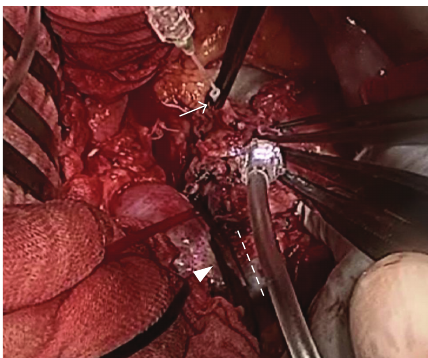
Figure 3: The left renal artery of the donor was cannulated for in situ perfusion (arrow). The isthmus was clamped during perfusion (arrowhead), and a divided fusion site of the isthmus was confirmed (dotted